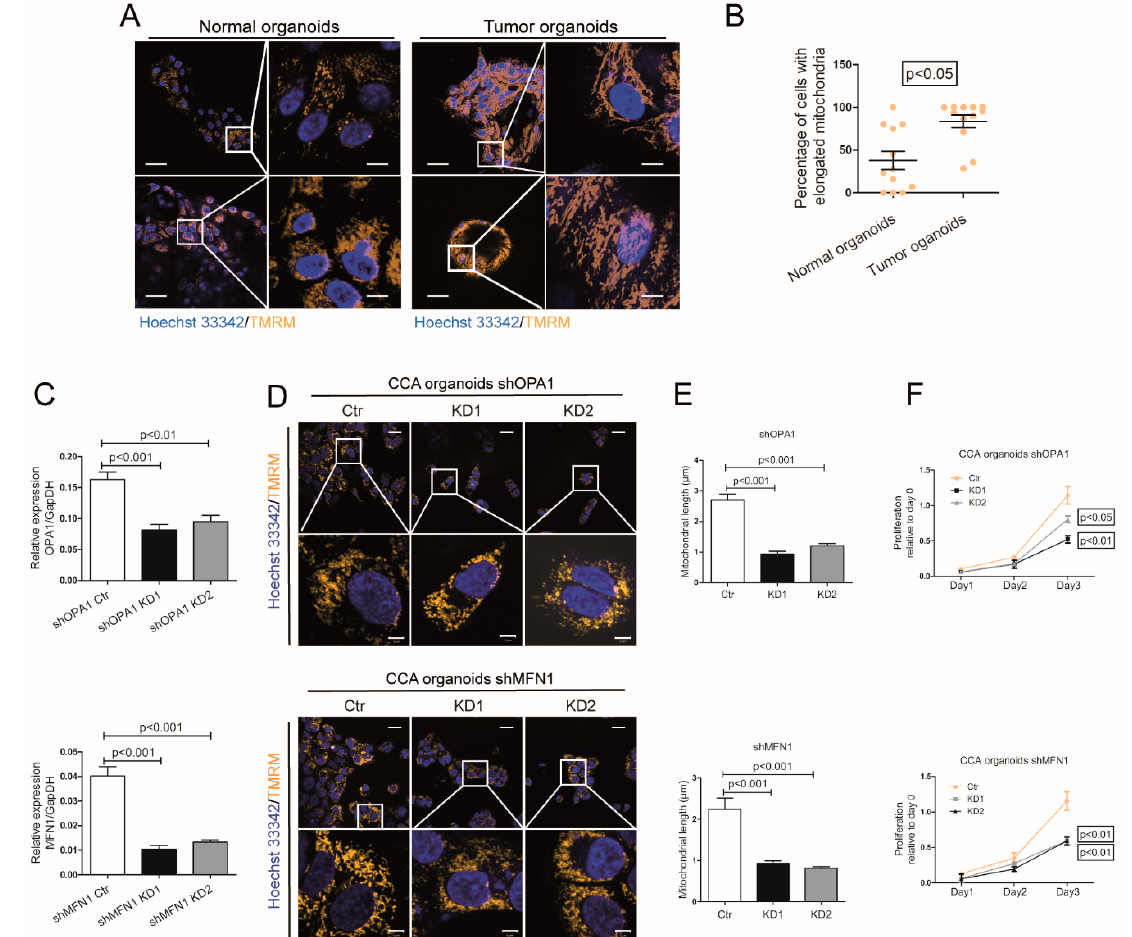
Figure 2. Silencing of OPA1 or MFN1 inhibits mitochondrial fusion and the growth of CCA organoids. ( A ) Representative confocal images of mitochondria with TMRM staining in in vitro cultured organoids from two tumor tissue, one matched adjacent liver tissue and one donor liver tissue. The white boxed regions were further magnified in the expanded images (right row). Scale bar = 50 µm (left row). Scale bar = 10 µm (right row). ( B ) Images of tumor and non-tumor “normal” liver organoids were quantified (Normal vs. Tumor: 37.93 ± 10.62 vs. 83.5 ± 7.34; n = 6 images/sample). ( C ) CCA organoids were transduced with mock lentivirus (Ctr) or shOPA1/shMFN1 lentivirus (KD1 and KD2) respectively. Gene knockdown efficiency of OPA1 was quantified by Real-time PCR (n = 6). ( D ) Representative live cell confocal images of mitochondria with TMRM staining in CCA organoids with OPA1/MFN1 knockdown. The white boxed regions were further magnified in the expanded images (lower row). Scale bar = 20 µm (upper row). Scale bar = 5 µm (lower row). ( E ) Quantified measurements of mitochondrial length in control and KD cells of CCA organoids (n = 3 images/sample). ( F ) The Alamar Blue fluorescence level of CCA organoids was measured at Day 0/1/2/3 for cell viability and data at day 0 was set as control of each group (n = 3). Histograms show means ± SEM with p value derived by the Mann Whitney test.